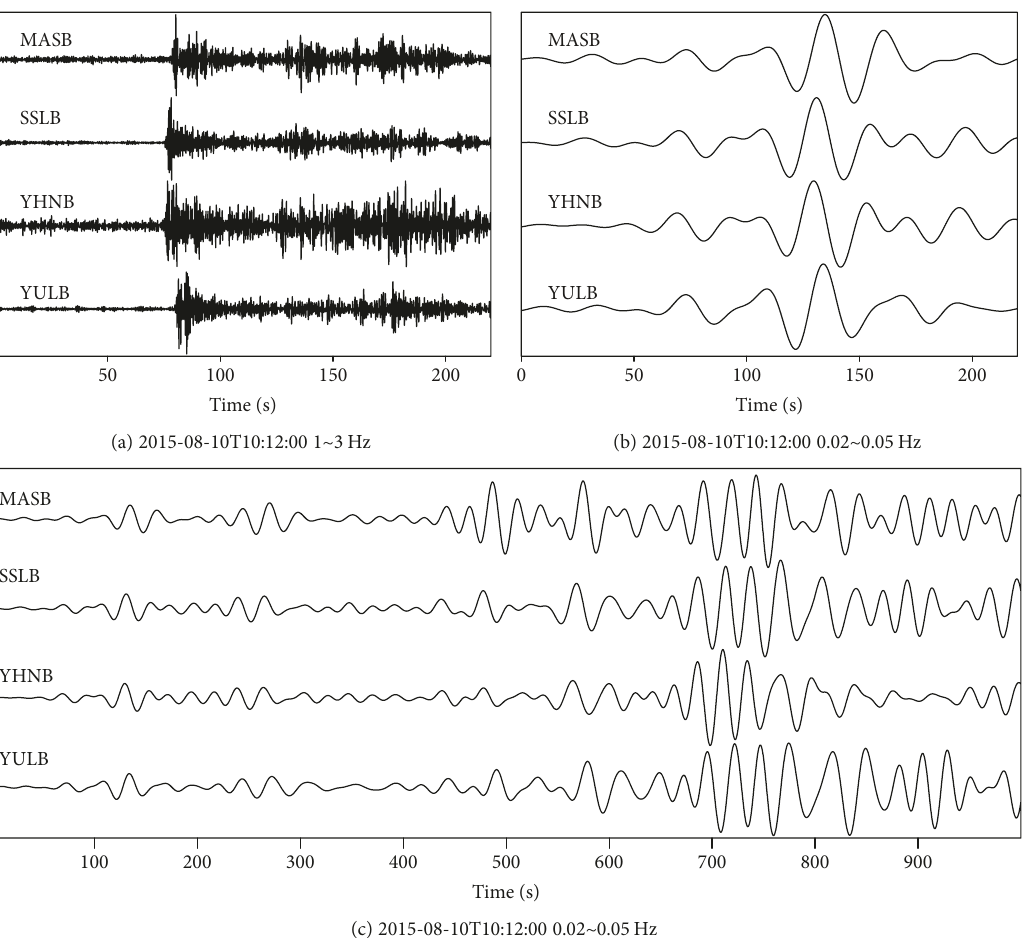
Figure 6: The vertical component broadband seismograms of a teleseismic event during the 2015 Typhoon Soudelor period. (a) The 220s-long waveforms bandpass- fi ltered between 1 and 3Hz and (b) the 220s-long waveforms bandpass- fi ltered from 0.02 to 0.05Hz. (c) The extended 1000s-long waveforms bandpass- fi ltered from 0.02 to 0.05 Hz, which con fi rm that these seismograms were generated by a teleseismic